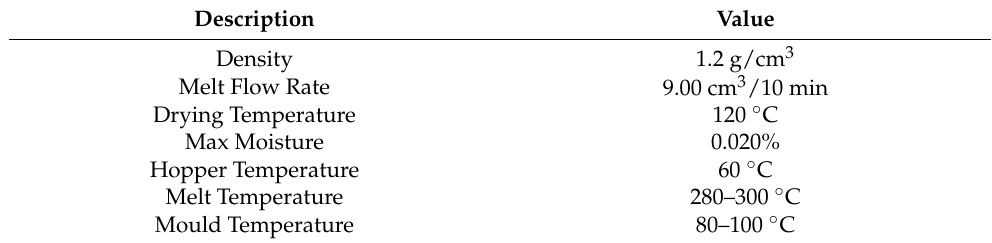
Table 3. Material Properties of Lexan 943-A.